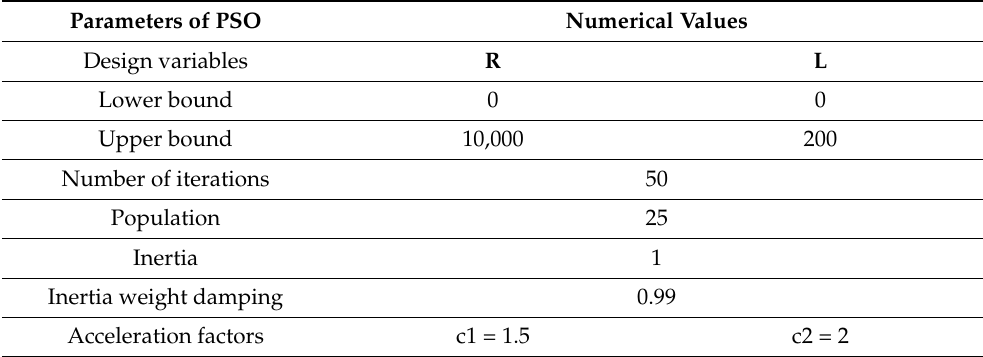
Table 2. Numerical values for the parameters of the optimization algorithms.